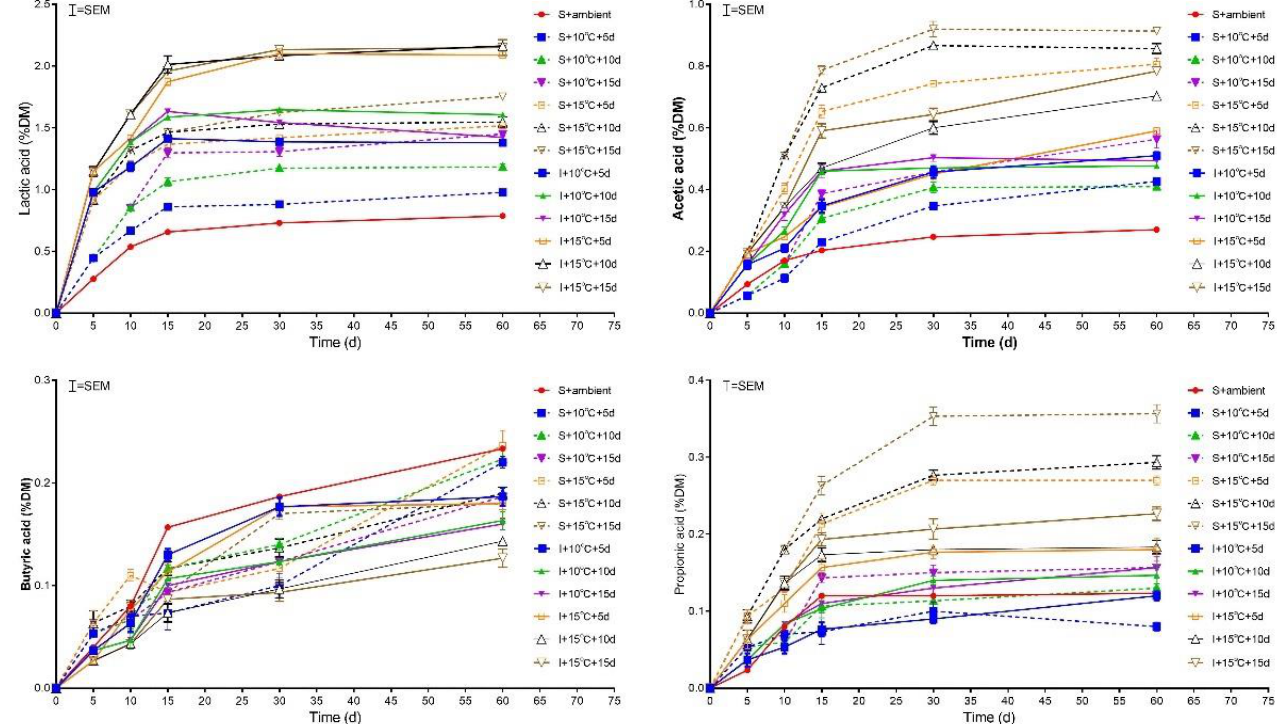
Figure 2. Dynamics of lactic acid, acetic acid, propionic acid and butyric acid in silage inoculated with inherent LAB (I) and commercial LAB (S) and stored at ambient temperature and stage-increased temperatures of 10 °C and 15 °C for 5, 10 and 15 days, respectively.